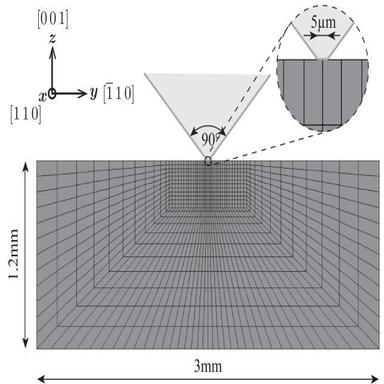
Finite element mesh used for the simulation of wedge indentation. The indenter is modeled by two flat surfaces that have an inclination angle of 90° and a flat tip of 5 μm width. Figure adopted from with permission from Elsevier.